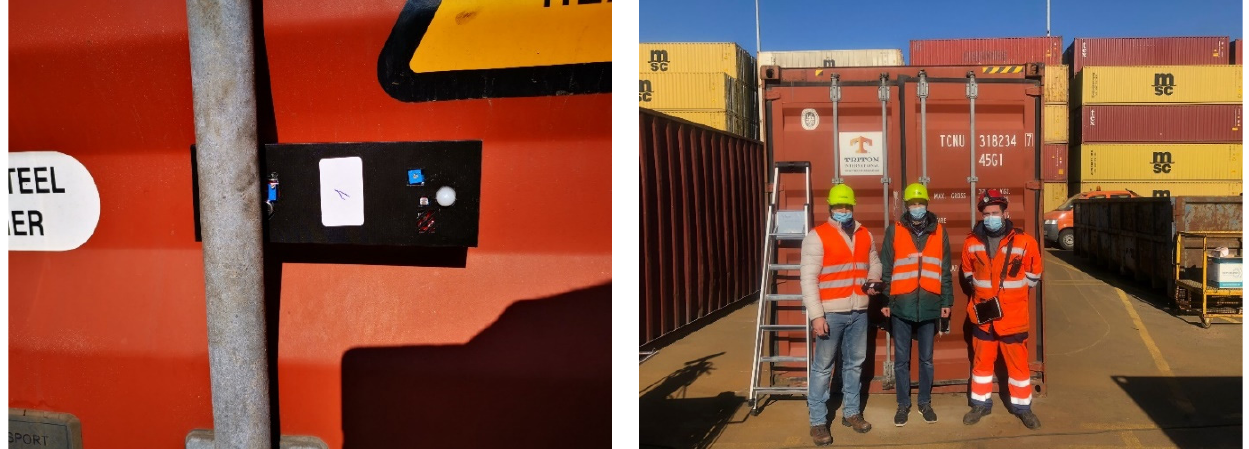
Figure 6. On the left is the experimental setup for impacts detection in the working environment of the Klaipeda LKAB “Smelte” containers terminal, and on the right is the work group in the operational environment of the repairs area and the test-bed container.